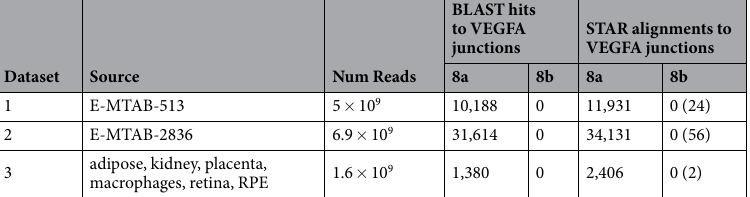
Table 1. Summary of datasets used, BLAST exact 22-base hits and STAR unique alignments to VEGFA junctions 8a and 8b. Paired reads are counted here as two separate reads. No reads supported existence of an 8b splice sites. Prior to removal of the two VEGFA xxx b transcripts from the ‘genes.gtf’ annotation file a small number of reads (indicated in brackets) were reported to align to the annotated 8b splice site but these had very limited overlap in exon 7 (see Supplementary Fig.